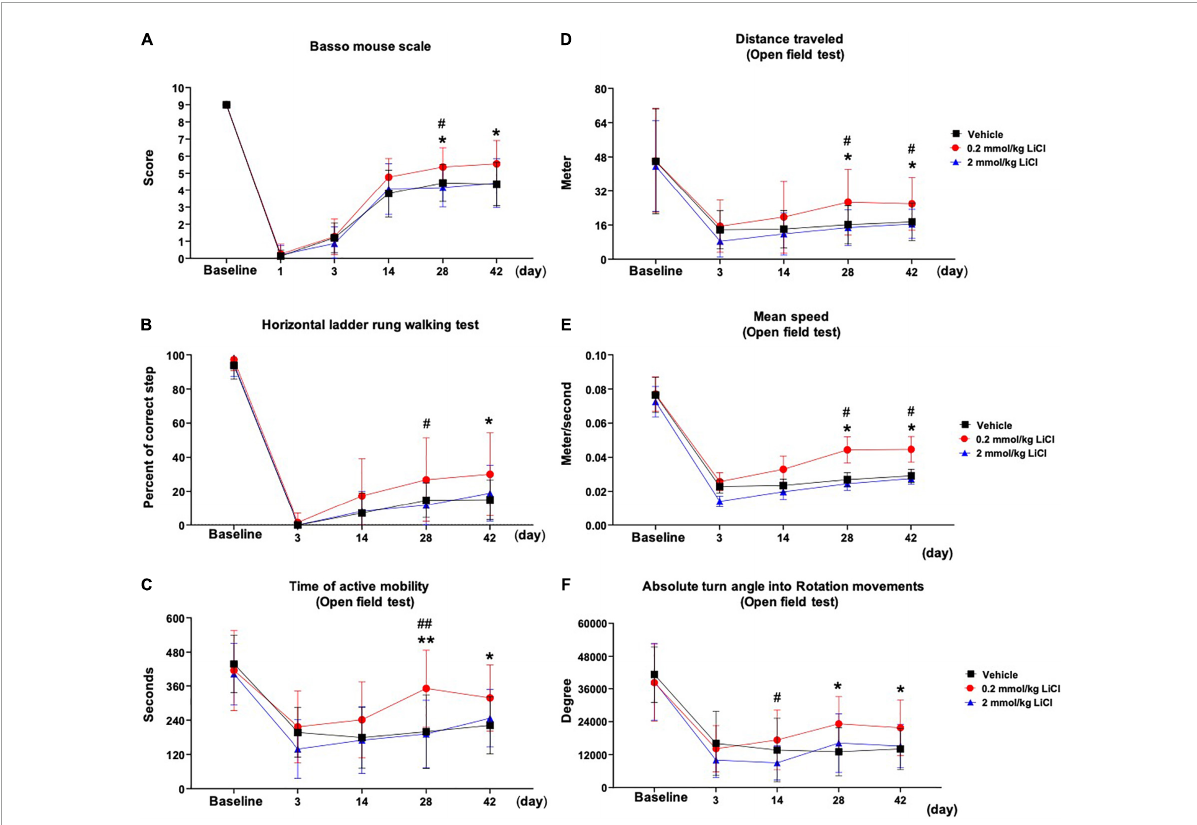
FIGURE1 Low-dose lithium enhances motor coordination recovery and spontaneous locomotor activity following spinal cord injury (SCI). Motor performance evaluated by (A) the Basso mouse scale and (B) the horizontal ladder rung walking test of mice exposed to right-sided spinal cord hemitransection at the T10 level, which were treated with vehicle or lithium (0.2 or 2 mmol/kg/day) for 56 days. Spontaneous motor activity evaluated by (C) the time of active mobility, (D) the total distance traveled, (E) mean speed, and (F) rotation movements in the open field test of the same mice exposed to spinal cord hemitransection, which were treated with vehicle or lithium (0.2 or 2 mmol/kg/day) for 56 days. Data are expressed as mean ± SD values ( n = 16 animals/group). ∗ p < 0.05/ ∗∗ p < 0.01 for 0.2 mmol/kg LiCl vs. vehicle; # p < 0.05/ ## p < 0.01 for 0.2 mmol/kg LiCl vs. 2 mmol/kg